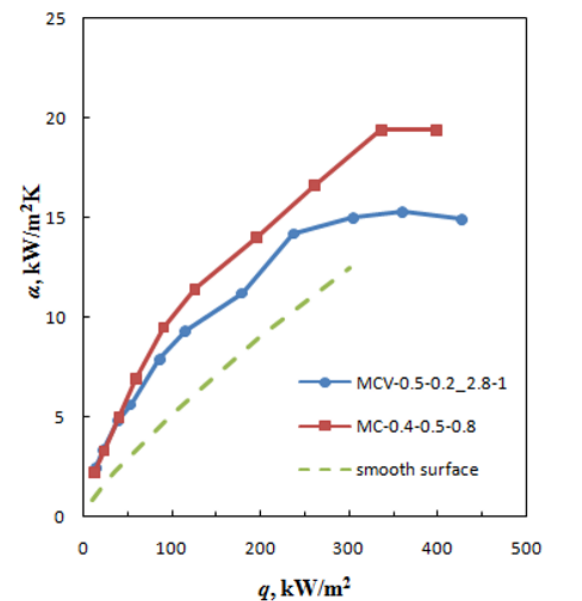
Fig. 7. Boiling curves for ethanol, heat transfer coefficient vs. heat flux.